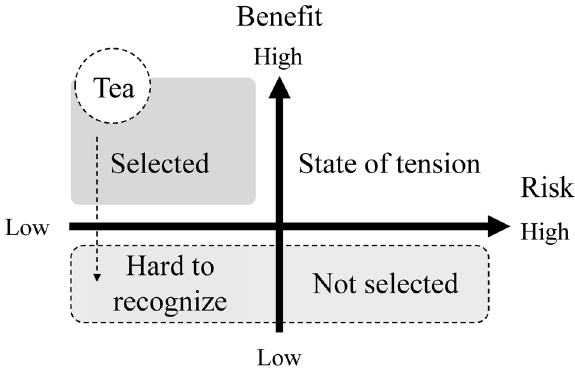
Fig. 2 Informed decision-making in light of the perceived risks and bene